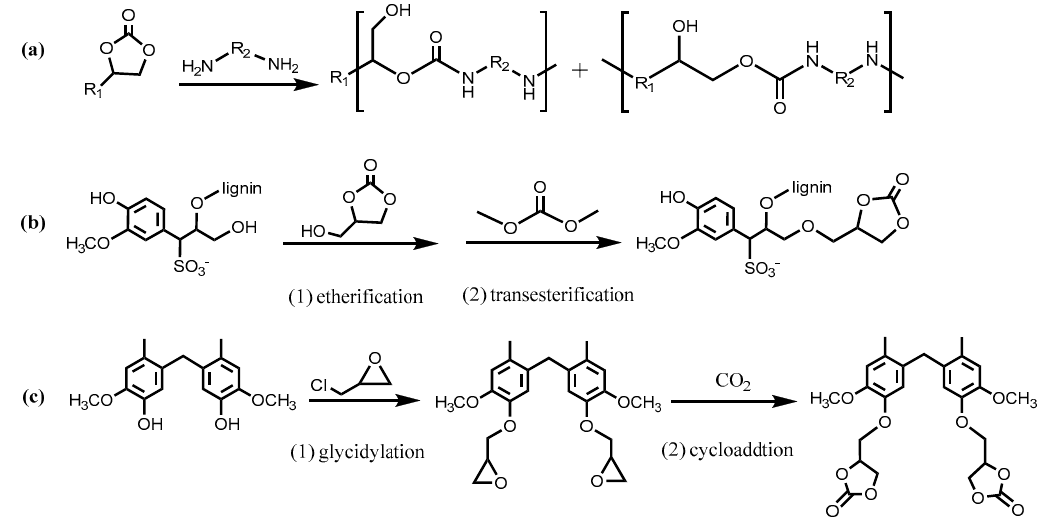
Figure 3. ( a ) Synthetic scheme of NIPU); ( b ) two-step synthesis of lignosulfonate-glycerol cyclic carbonate; ( c ) cyclic carbonate synthesized from CO 2 fixation in epoxides [24,25].